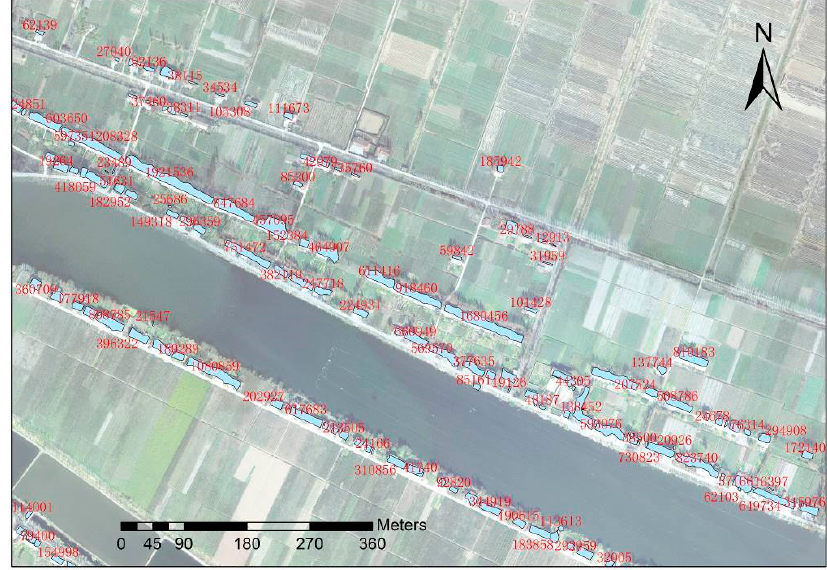
Figure 13. Example of final flood loss distribution map for brick–wood buildings, each marked with their loss value.